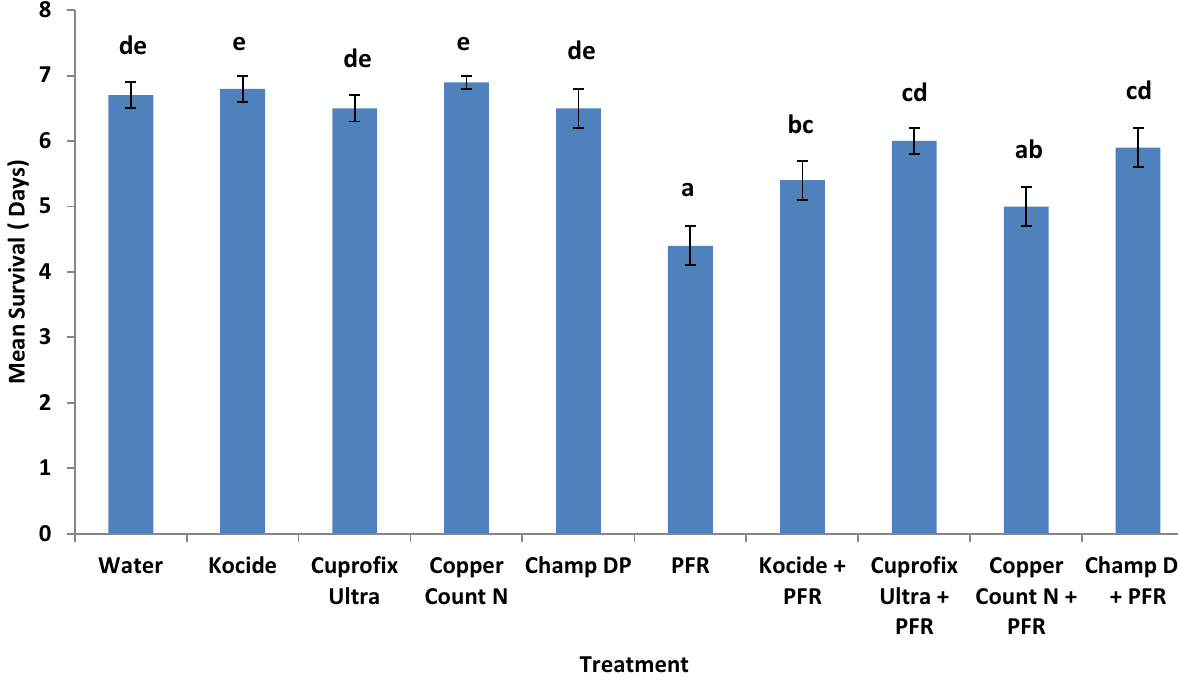
Figure 5. Mean survival (days) for D. citri exposed to copper-based fungicide treated citrus leaves prior to application of Isaria fumosorosea (PFR) over 7 days. Data are mean ± SEM of three tests (10 replicates per test) and letters indicate significance ( P < 0.05, Duncan's multiple range test).